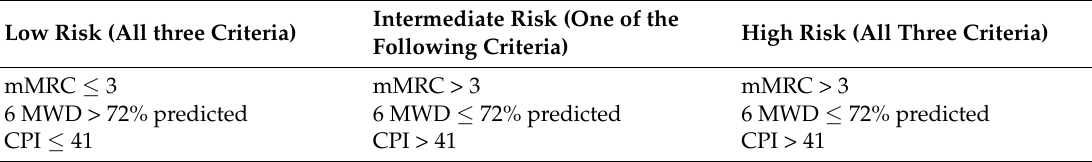
Table 6. Risk stratificatiOn ScorE (ROSE